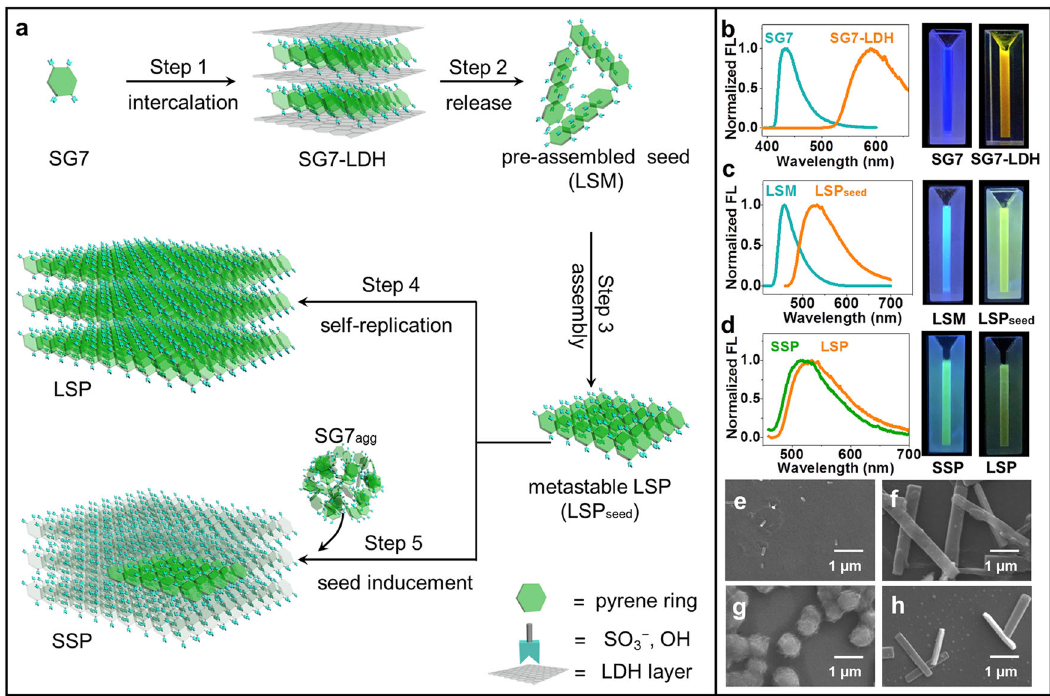
Fig. 1 The growth process and characters of LSP and SSP. a Schematic presentation for the formation of the LSP. Normalized FL spectra and photos under UV light of b SG7 and SG7-LDH in CH 3 OH; c fresh LSM and metastable LSP (LSP seed ); d fresh SSP and LSP. SEM images of e metastable LSP f LSP after aging for 12 h g SG7 agg , and h fresh The wide excitation range of LSP is also in line with the long-range π – π stacking rather than a single molecule (Supplementary Fig. 14).